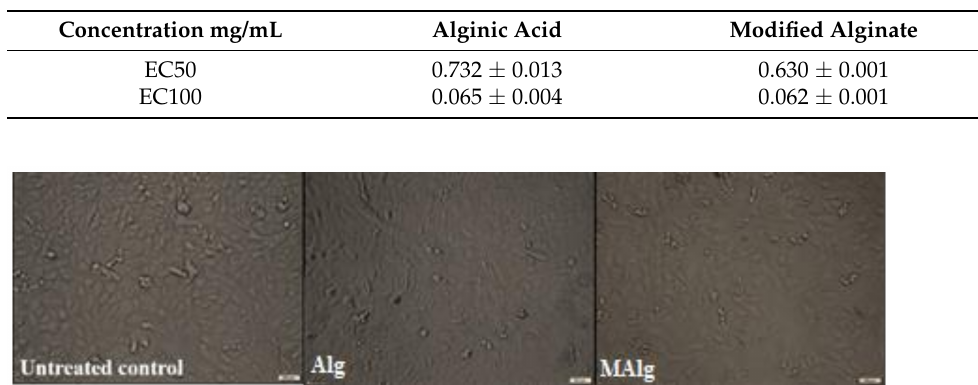
Figure 10. Morphological changes in Wi-38 cells after incubation with the alginic acid and algi- nate